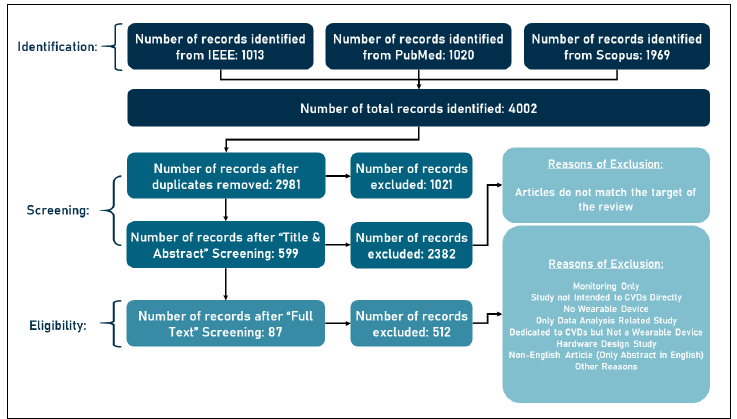
Figure 3. Flow of information through the different phases of a systematic